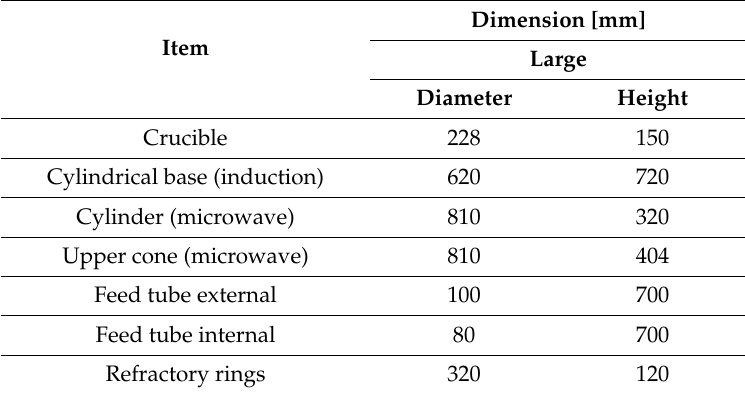
Table 4. Dimension of optimized cavity.